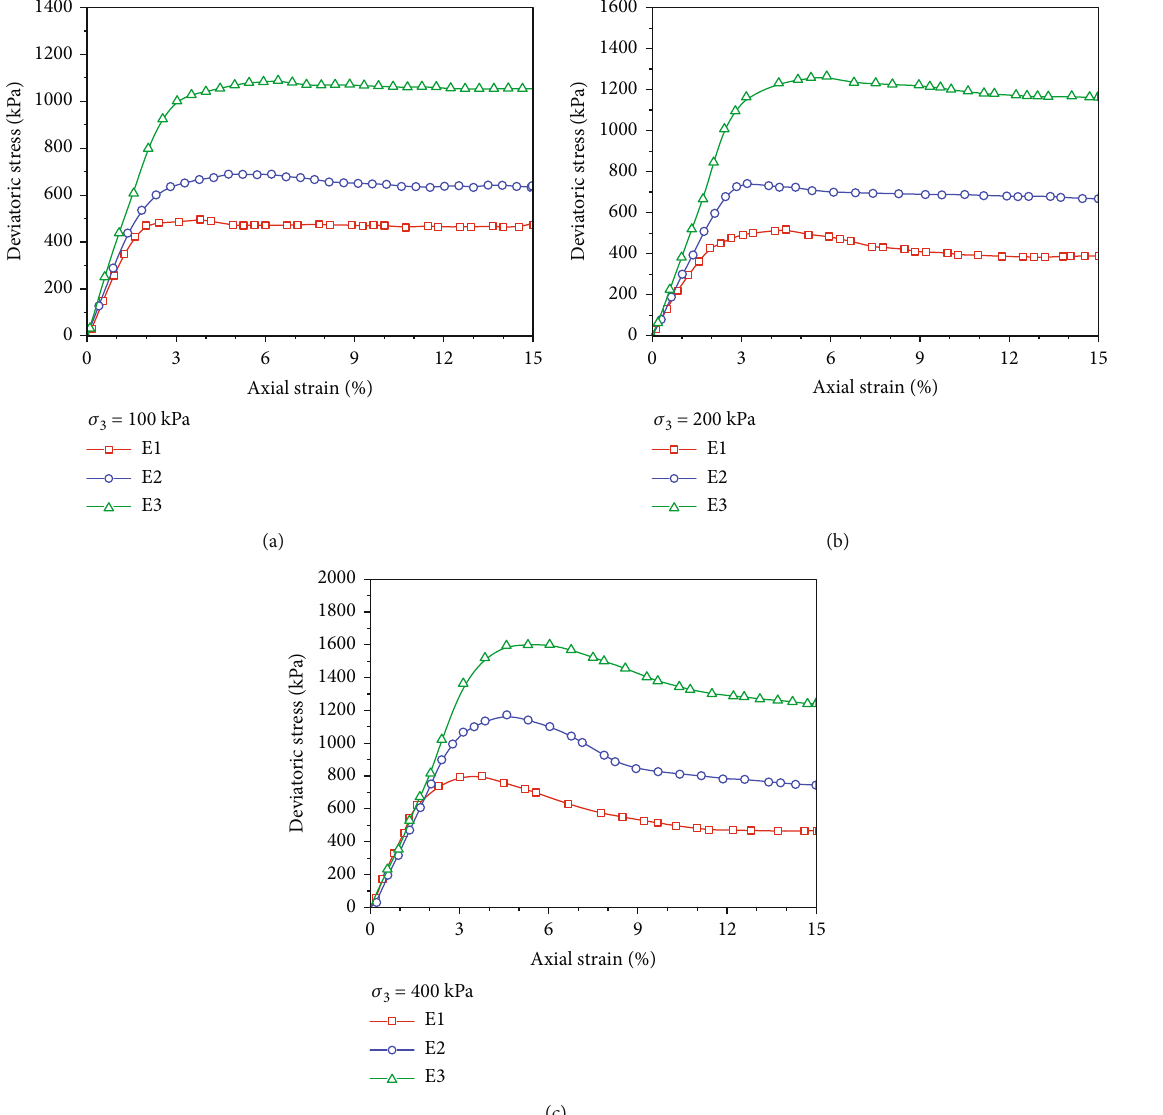
= 100 kPa ; (b) σ = 200kPa ; and (c) 3 3